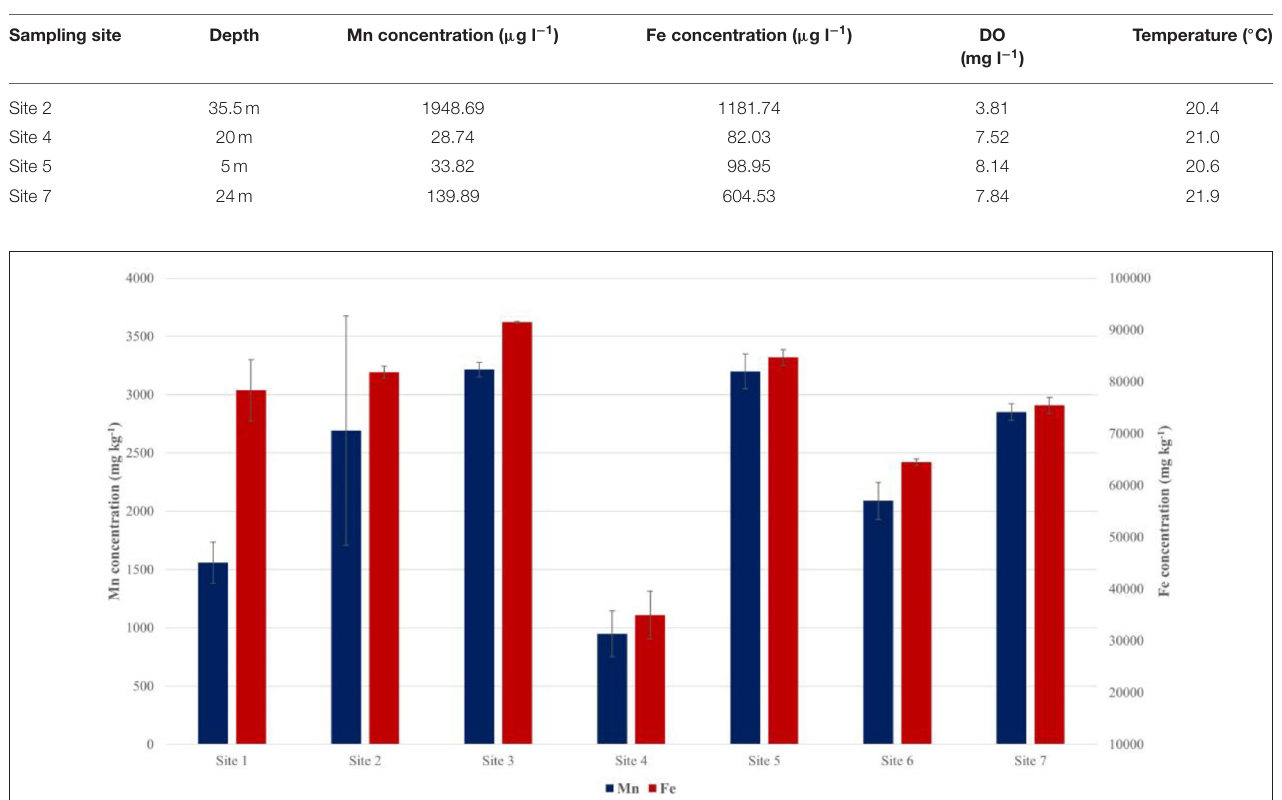
TABLE 1 | Total Mn and Fe concentrations in water samples collected near the sediment/water interface at sites in the Blyderiver dam located further away from the dam wall (May 2016).